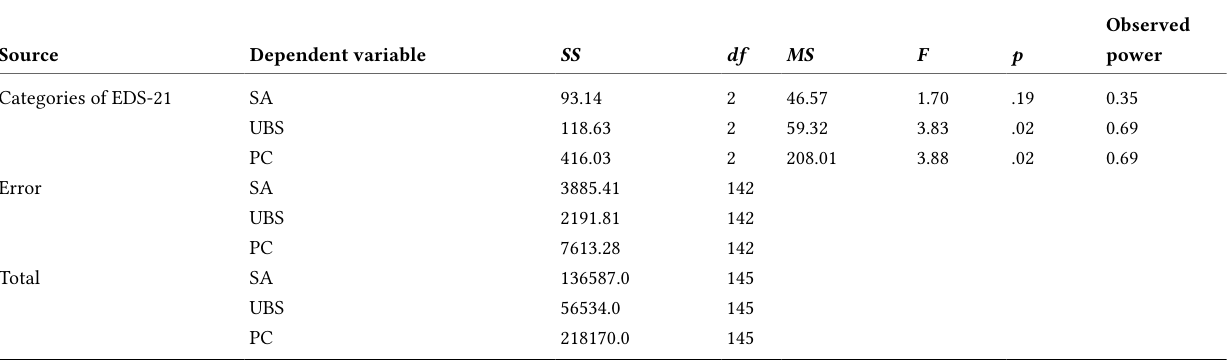
One-Way ANOVA for Male Gym-Goers Between Categories of EDS-21 and Areas of